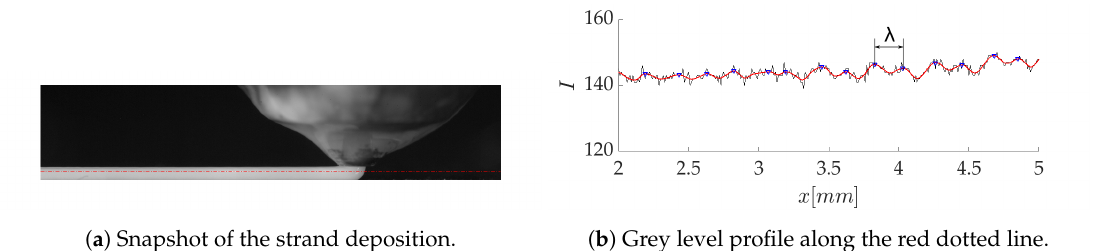
Figure 21. High-speed snapshot of the deposited strand for h / d = 0.75, V / U = 1.27 and V = 14.7